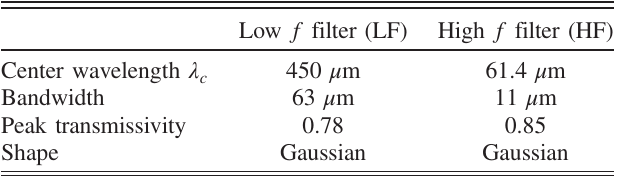
TABLE II. Parameters of CTR filters.